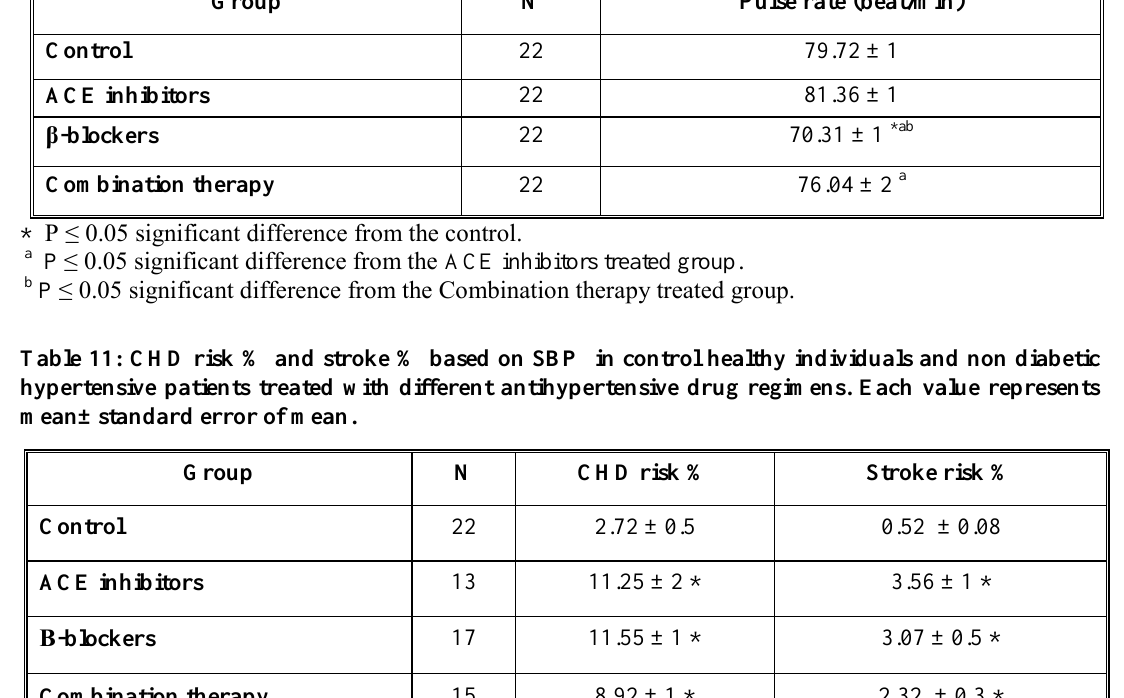
Table 10: Pulse rate in control healthy individuals and hypertensive patients treated with different antihypertensive drug regimens. Each value represents mean± standard error of mean.